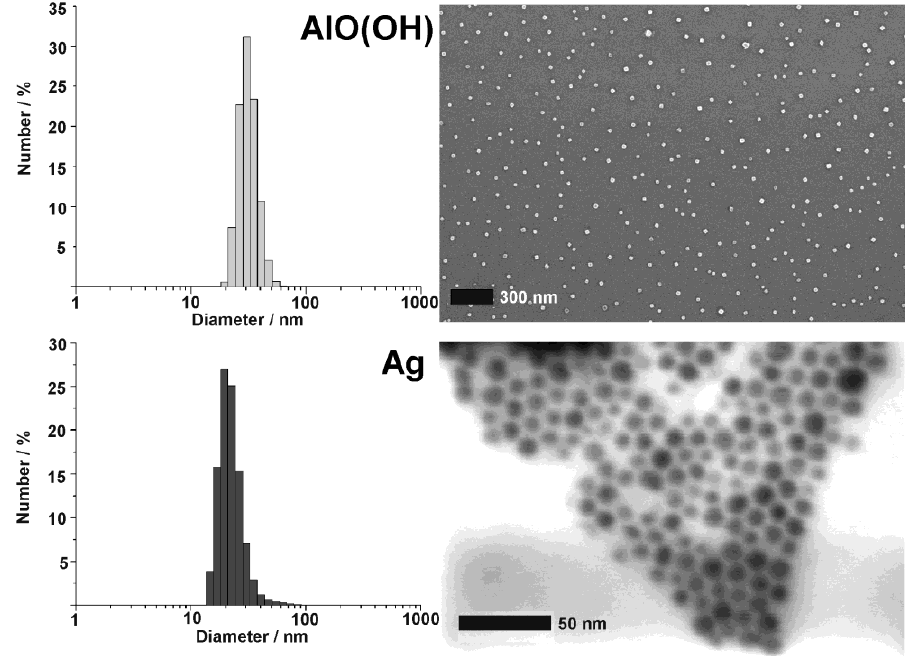
Figure 8. DLS and SEM/STEM overview images showing size and size distribution of as-prepared AlO(OH) and Ag hollow spheres (modified reproduction from